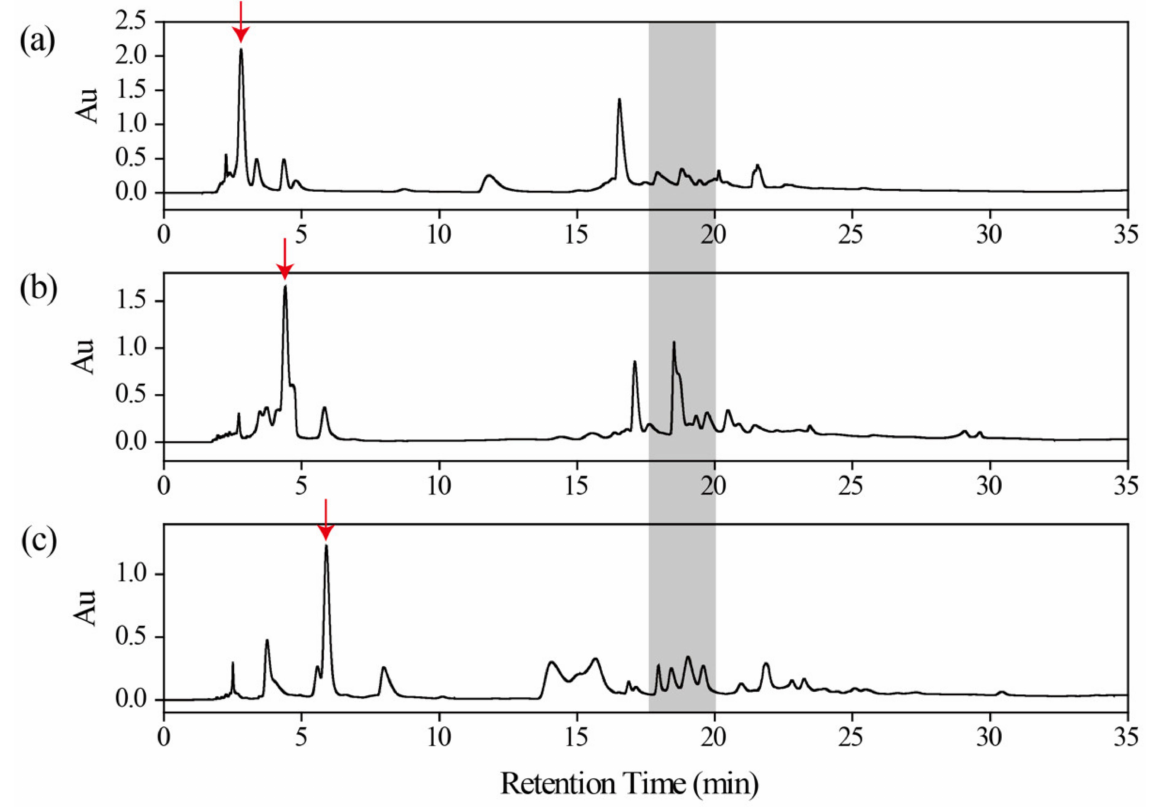
Figure 3. HILIC chromatograms of polar fraction at 254 nm on ( a ) BEH Silica column (150 × 4.6 mm i.d., 5 µ m), ( b ) Inertsil Diol column (150 × 4.6 mm i.d., 5 µ m) and ( c ) XAmide column (150 × 4.6 mm i.d., 5 µ m). The red arrow indicated the polar compounds. The gray color indicated chromatographic peaks distributed on the above three